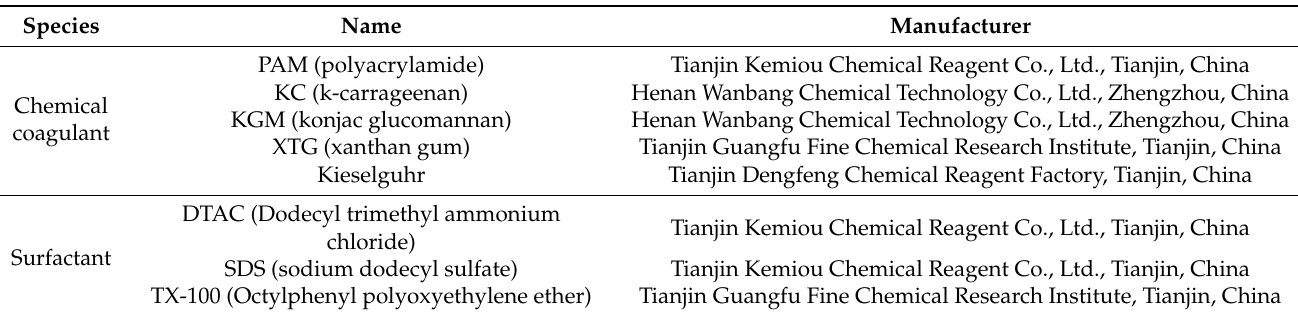
Table 1. Chemical coagulants and surfactants used in the experiments.